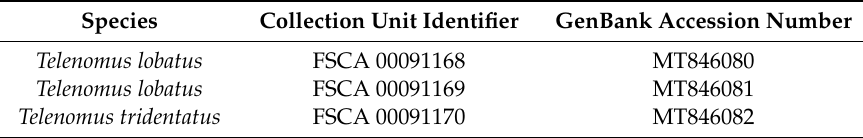
Table 3. Accession number of CO1 sequences of Telenomus species.